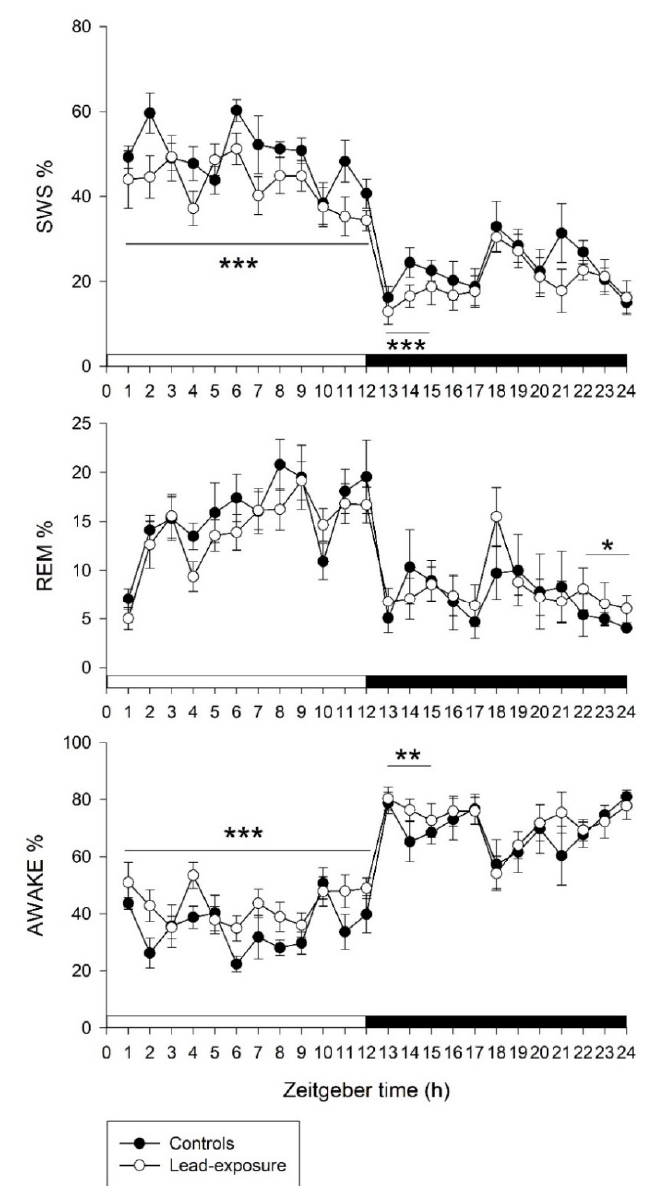
Figure 1. A 24 h panel of sleep–wake cycle between lead-exposure and control rats. Values on y-axis represent percentage of each sleep stage. Values on x-axis represent circadian Zeitgeber time points. SWS, slow wave sleep; REM, REM sleep; awake, wakefulness period. Data are represented as mean ± standard deviation. The two groups within 12h-interval or 3h-interval were compared by using a Mann–Whitney U test. * p < 0.05, ** p < 0.01 and *** p < 0.001 versus the control